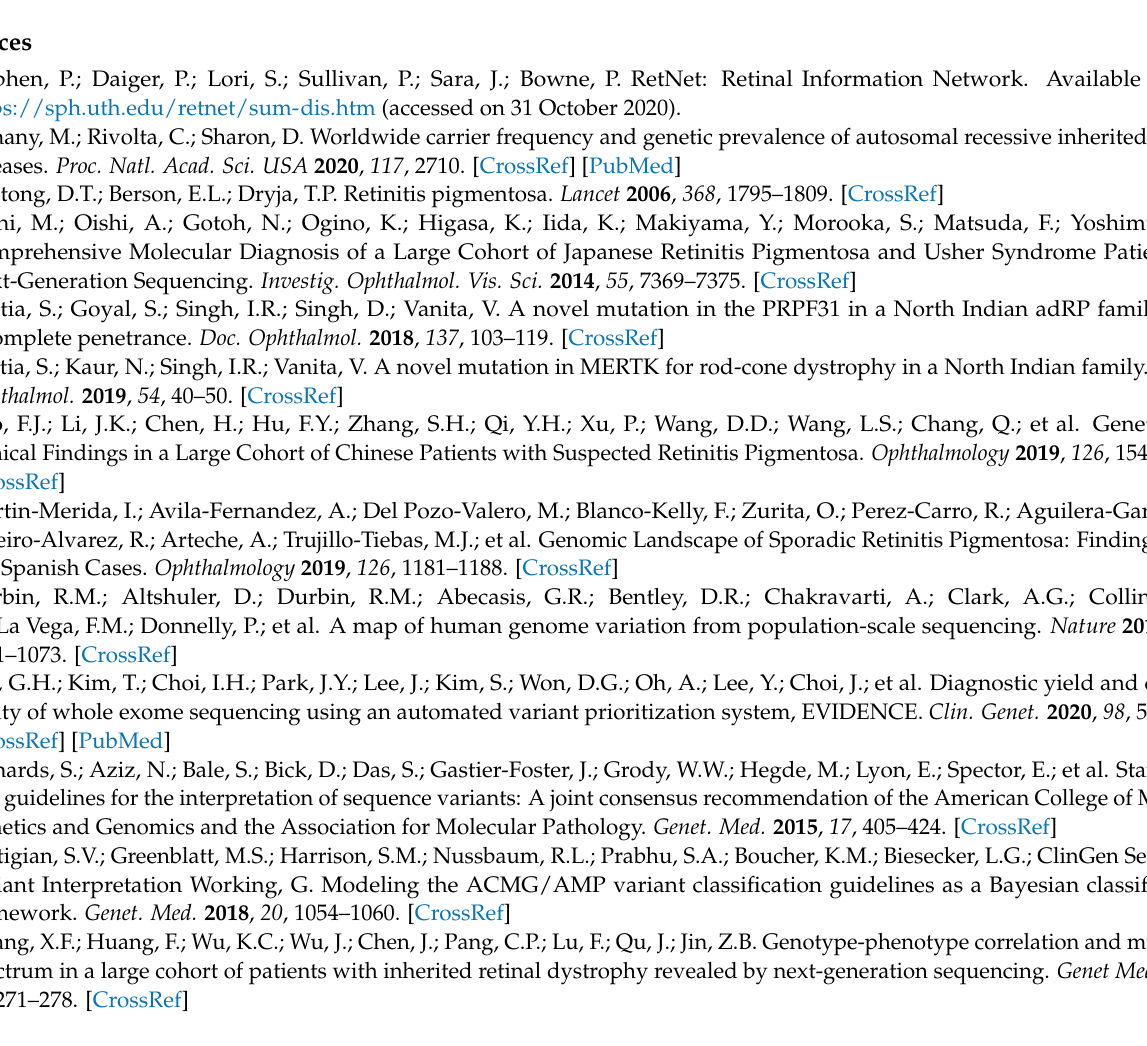
Table S3: Clinical characteristics according to the presence of family history; Table S4: A list of variants detected in targeted next-generation sequencing and whole exom sequencing; Figure S1: Ocular characteristics of patients with unexpected genetic results; Table S5: List of patients with inconclusive results; Figure S2: Clinical characteristics of patients with inconclusive